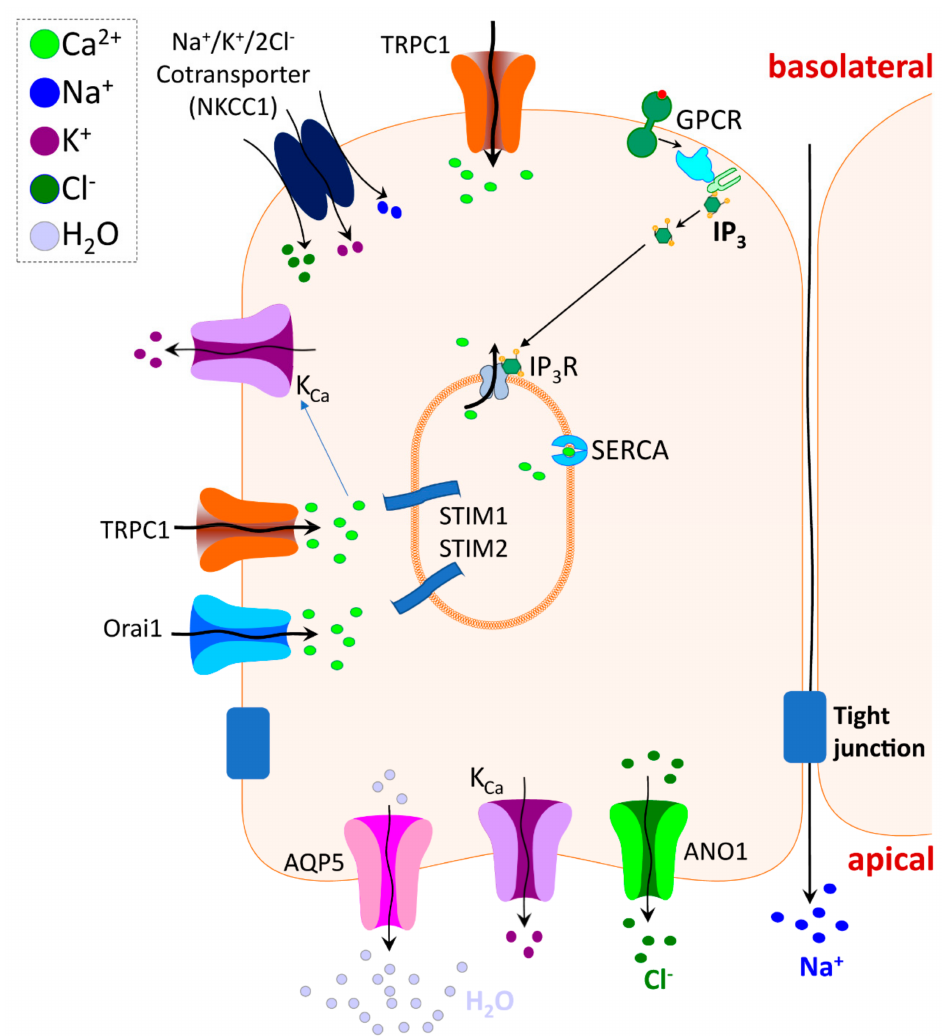
Figure 1. Ca 2+ signaling and ion channel regulation underlying salivary gland fluid secretion. Salivary gland acinar cell (depicted in the figure) secretes fluid composed of water and electrolytes in response to neurotransmitter stimulation of plasma membrane receptors and consequent elevation of cytosolic [Ca 2+ ] ([Ca 2+ ] i ) (see description in the